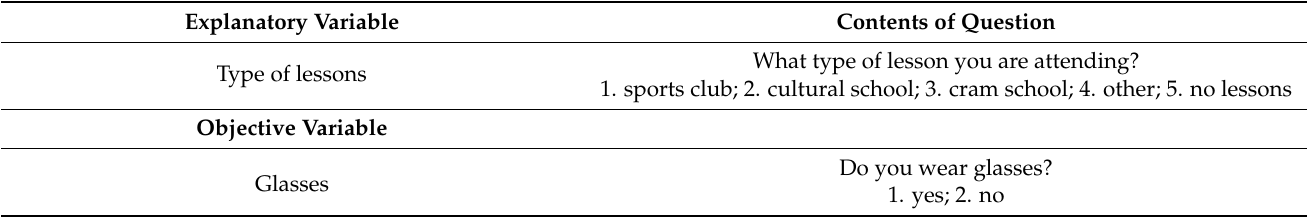
Table 1. Question content and options for the explanatory variable and objective